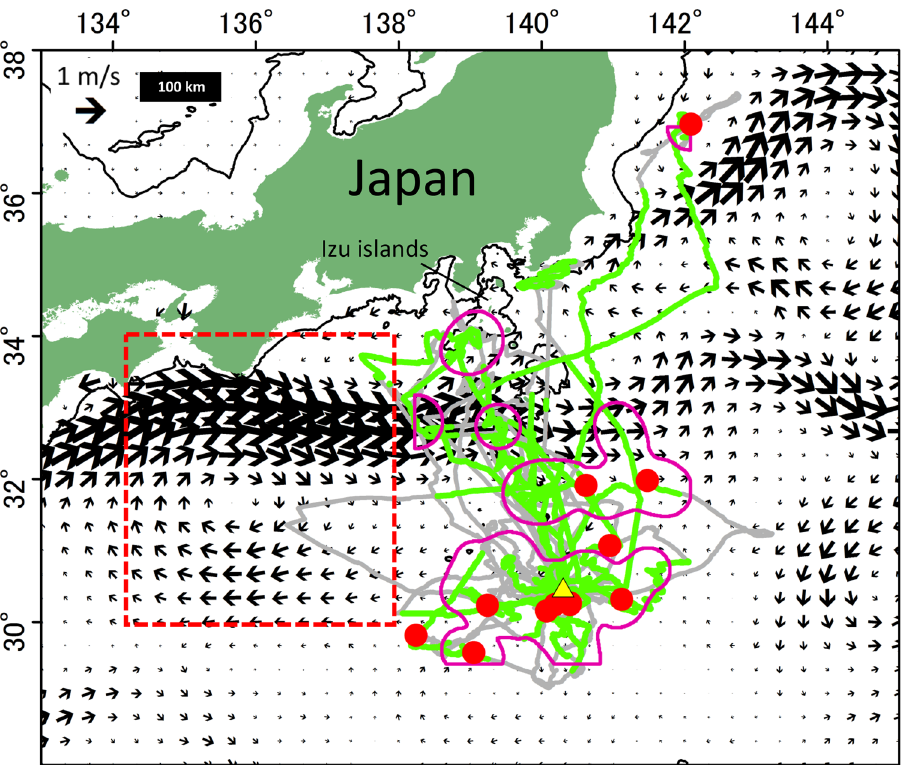
Figure 1. Distribution of marine floating debris (red circles) encountered by black-footed albatrosses at sea in relation to their foraging area (purple lines: 95% kernel density contour of the on-water bout locations where the birds fed on squid or fish confirmed from video footage). GPS tracks of 23 foraging trips made by 13 birds from Torishima (yellow triangle) are shown by gray lines, with green sections symbolizing when concomitant video records were available. Black arrows show surface ocean current during 15 February–2 March 2017, when field survey was conducted. Isobaths of 500 m are shown by black line. Red square represents study area of